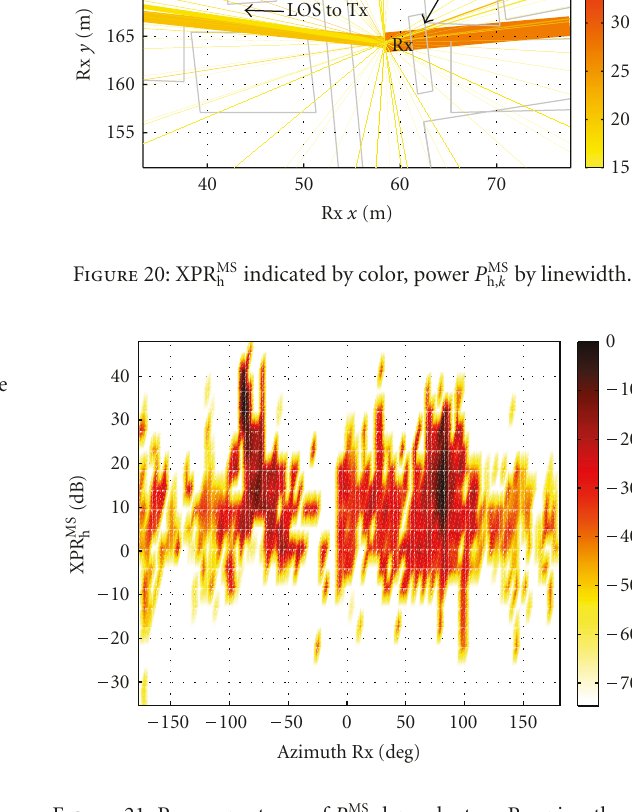
dependent on Rx azimuth and t h